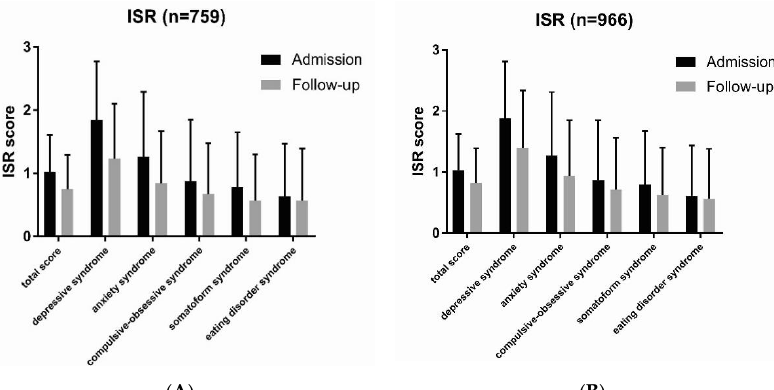
Figure 6. Symptom loads at admission and follow up calculated using the BOCF technique. ( A ) For patients with complete datasets ( n = 759), improvements in symptom loads were still significant at follow-up. ( B ) For all patients ( n = 966) and using the BOCF technique for the 207 patients lost to follow-up, the positive e ff ect of the multimodal therapy on patients’ symptom loads was still evident with high statistical significance at